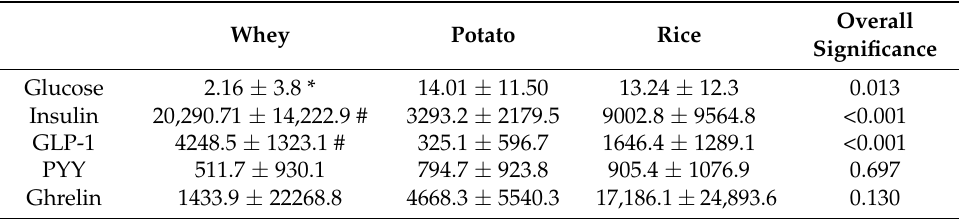
Table 3. Mean ( ± SD) total iAUC for blood glucose, plasma insulin, GLP-1, PYY and